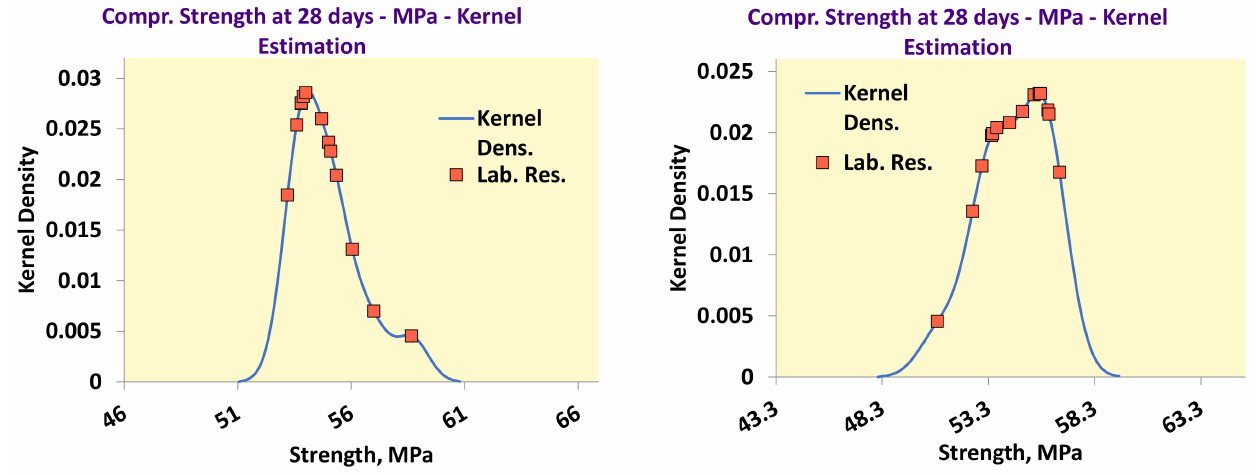
Figure 1. Examples of kernel density plots.